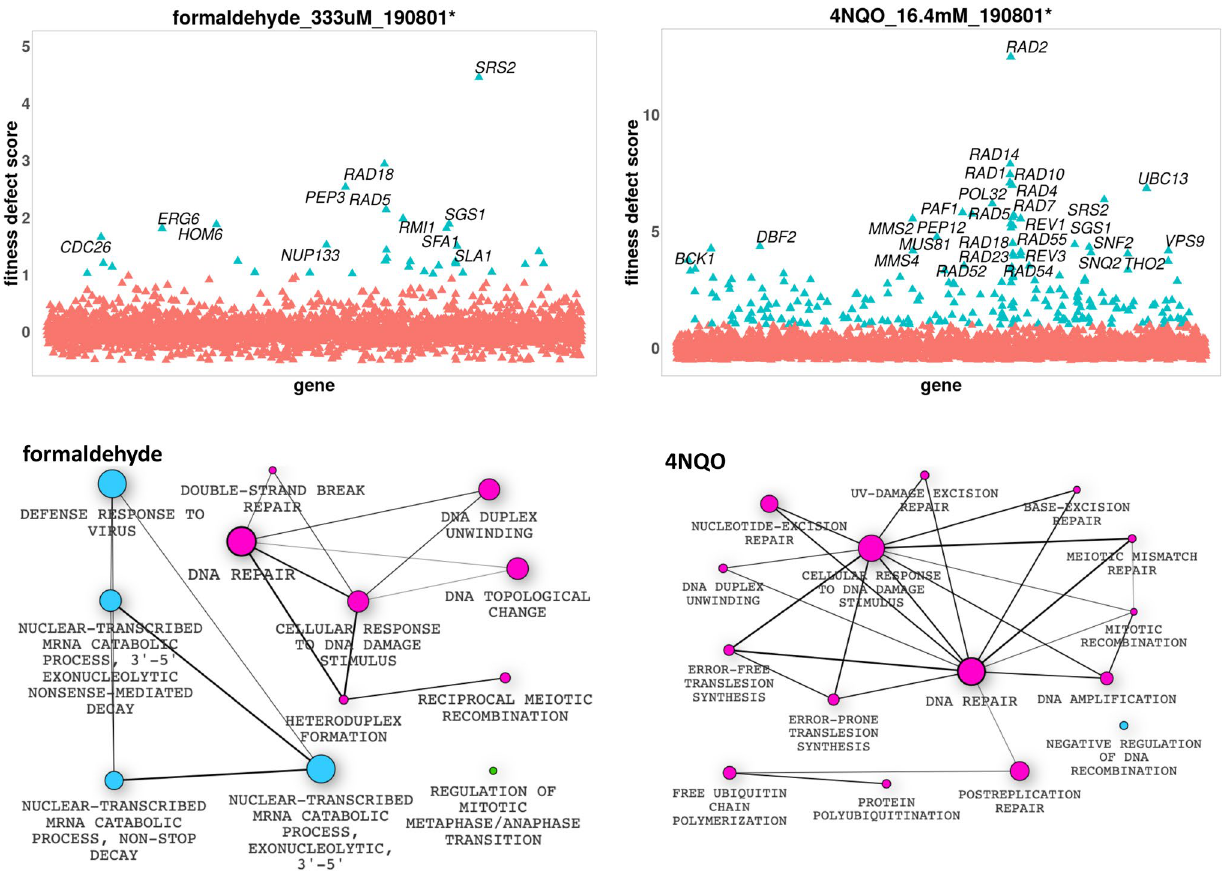
Figure 10. Genes and pathways whose deletion strains were affected by formaldehyde and 4NQO. Formaldehyde sensitized strains lacking CDC26 , RAD5 and RAD18 which are involved in DNA repair process. Similarly, 4NQO induced sensitivity for strains deleted for RAD2 , RAD14 , RAD10 , MMS2 and MUS81 , involved in DNA repair. As can be seen from the figure, many affected genes are those involved in cell cycle and DNA repair. Not all pathways at significant FD score are shown, e.g. chromatin remodelling in 4NQO. Plots were generated using the Bioconductor program v3.12, https:// www. bioco nduct or.